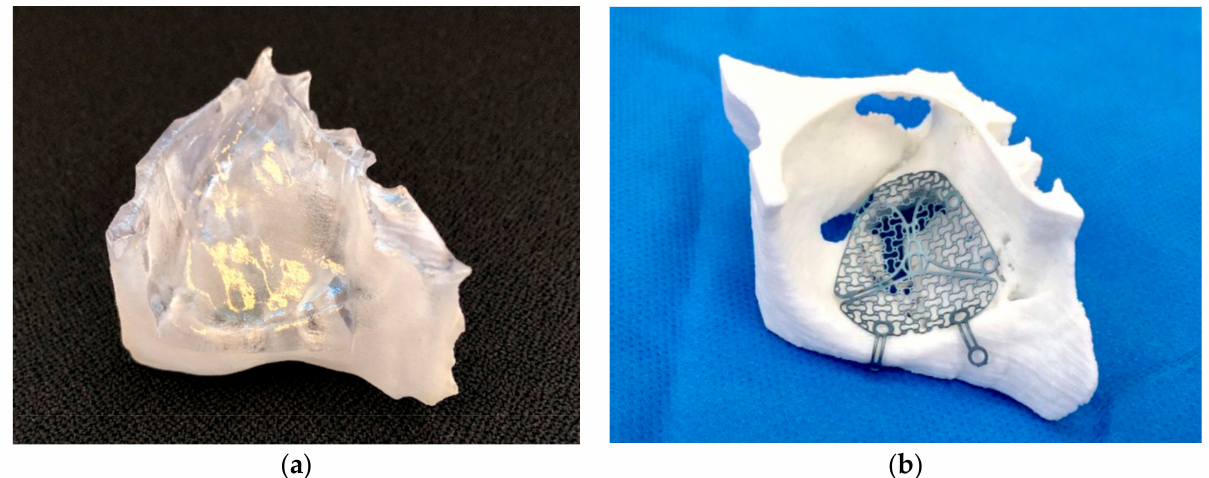
Figure 2. Overview of the used materials and techniques: ( a ) individual, virtually reconstructed right patient orbit (region of interest) printed with Med610 material; ( b ) individualized titanium mesh (Medartis MODUS OPS 1.5) on a 3D-printed right orbital model for the intervention